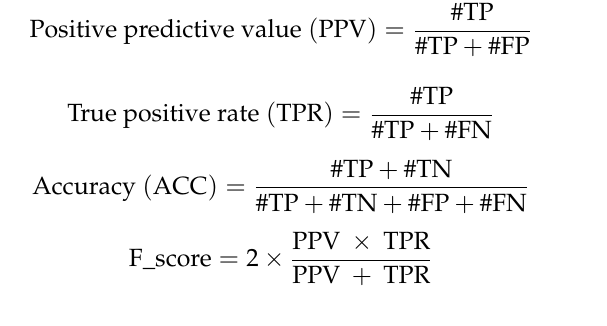
Table 5. Accuracies of arrow marking recognition by our method (unit: